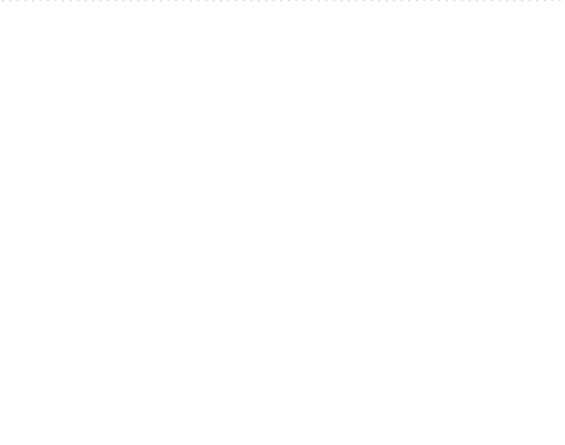
Figure 6. The expression profiles of HaNAC genes in different organs and under PEG stress based on transcriptome data from SRA. The legend represented a logarithmic normalized TPM. ( A ) HaNAC gene expression profiles in different organs. ( B , C ) HaNAC gene expression profiles in leaves and roots after 15% PEG stress treatment, respectively.